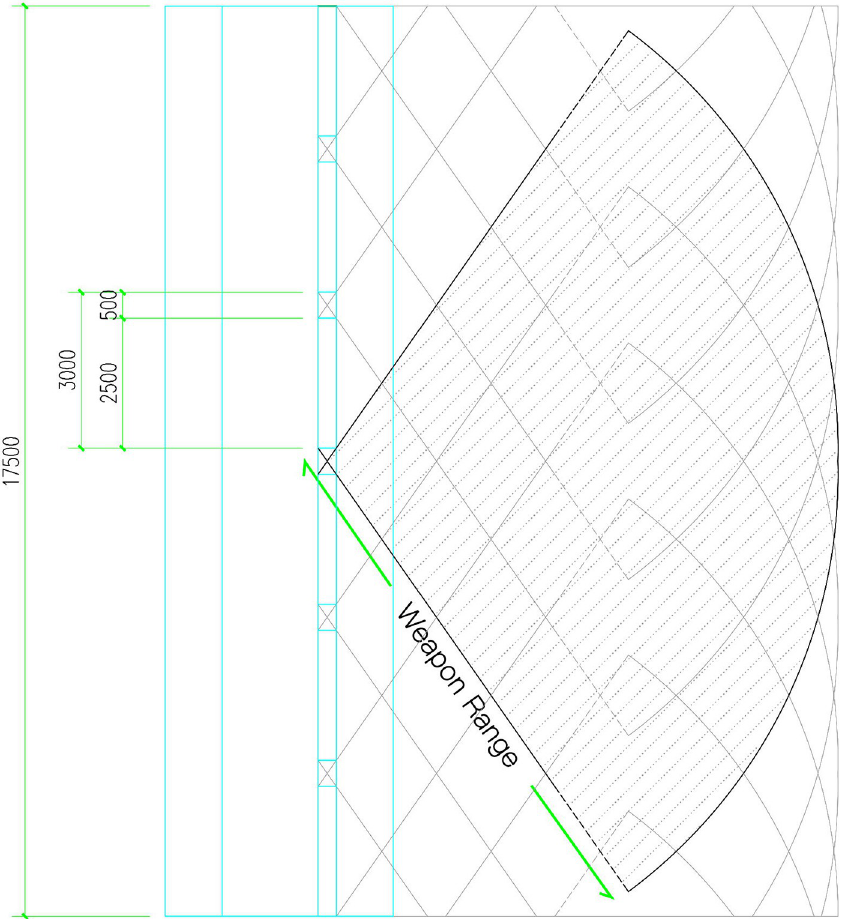
Fig 6. Fan-shaped firing range of a single battlement